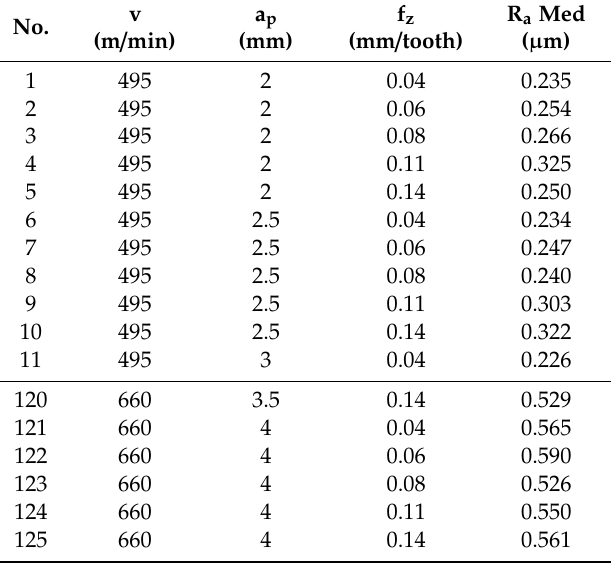
Table 8. R a med measurements according to central composite design [22], pag.